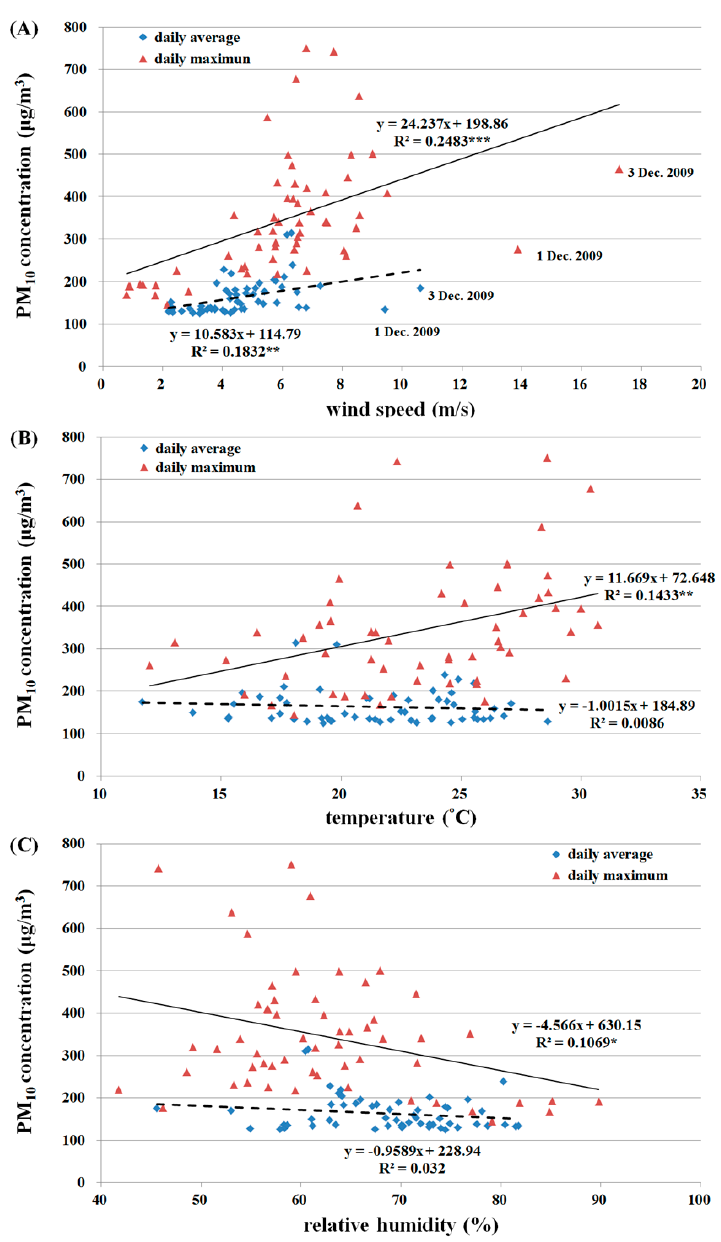
Figure 8. Relationship between daily average/maximum PM 10 and ( A ) wind speed; ( B ) temperature; and ( C ) relative humidity. Dashed lines are regression lines of daily average PM 10 and bold lines are regression lines of daily maximum PM 10 .